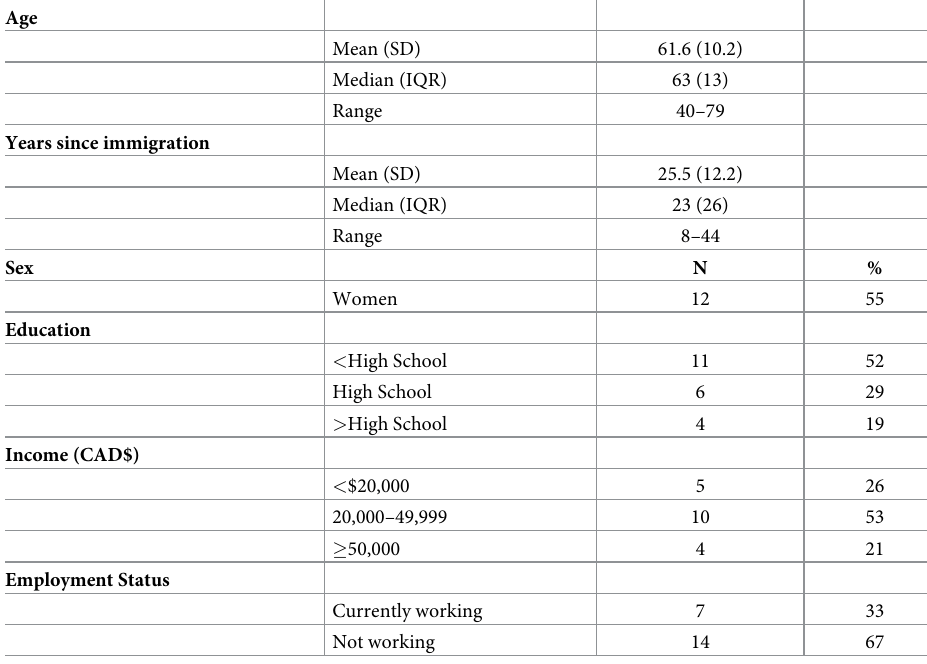
Table 2. Focus group discussion participants’